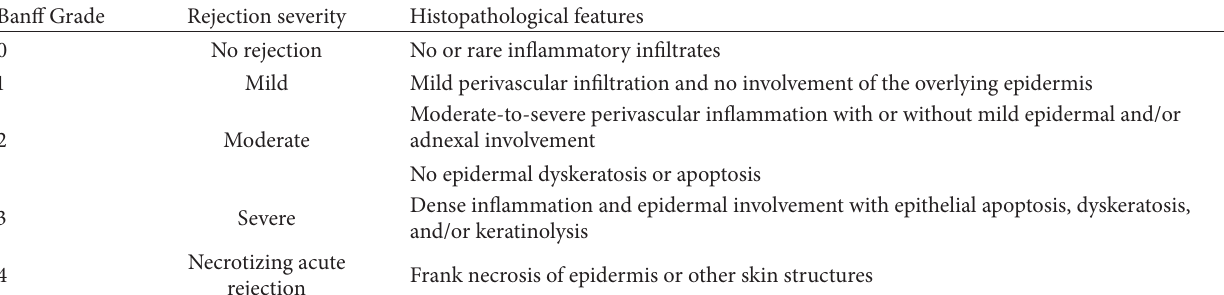
Table 2: The Banff 2007 working classification of skin-containing composite tissue allograft pathology